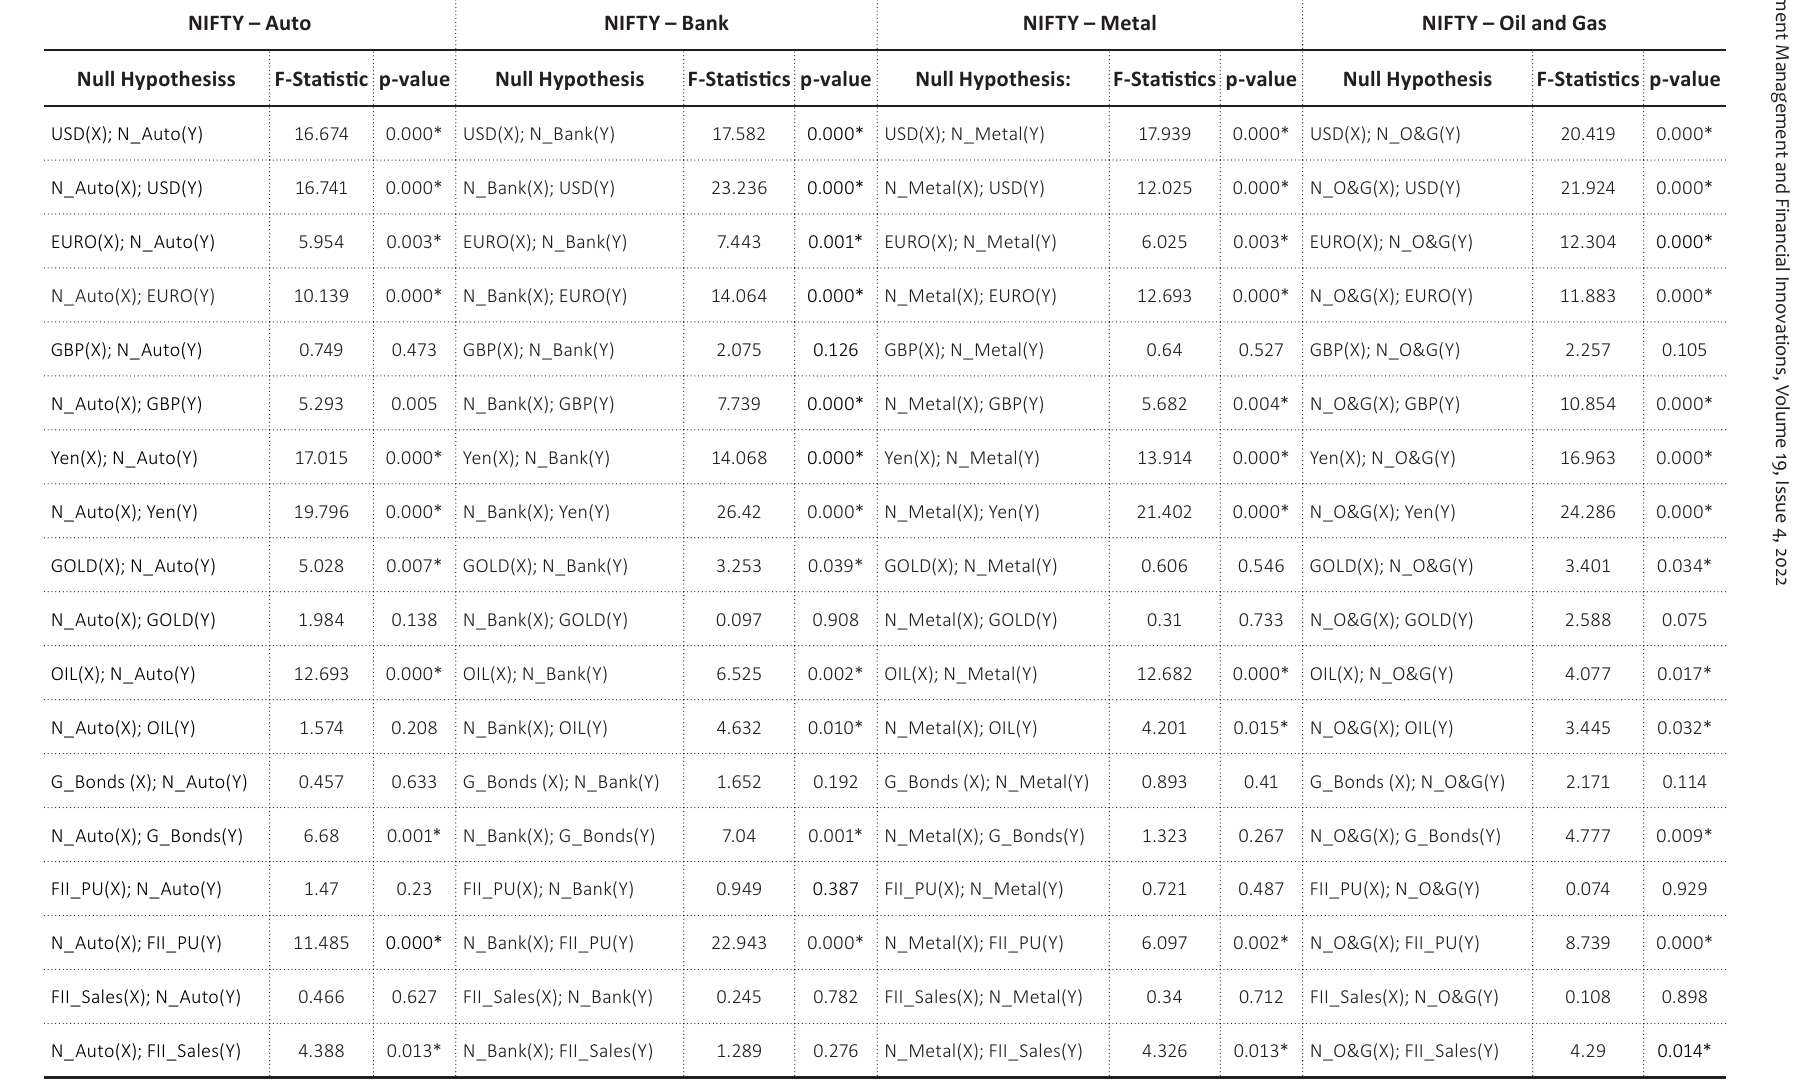
Table A2. Granger causality test results of NIFTY – Auto, Bank, Metal, Oil and Gas